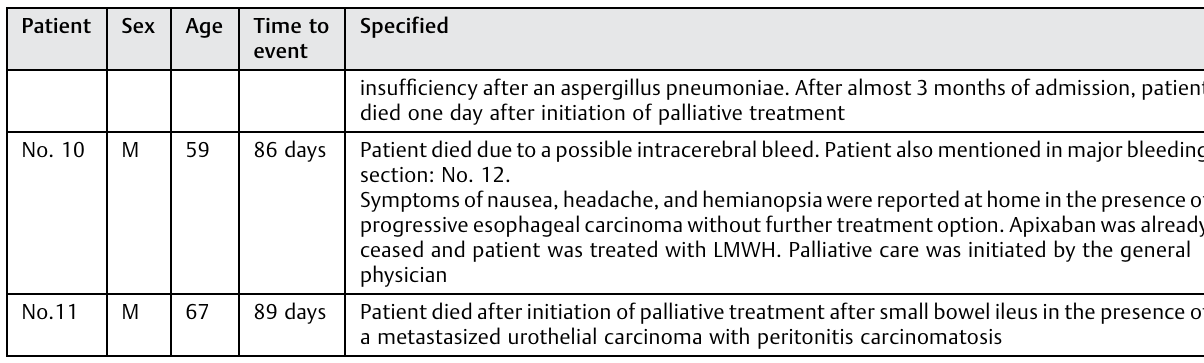
Table 5 Other reported side effect of apixaban